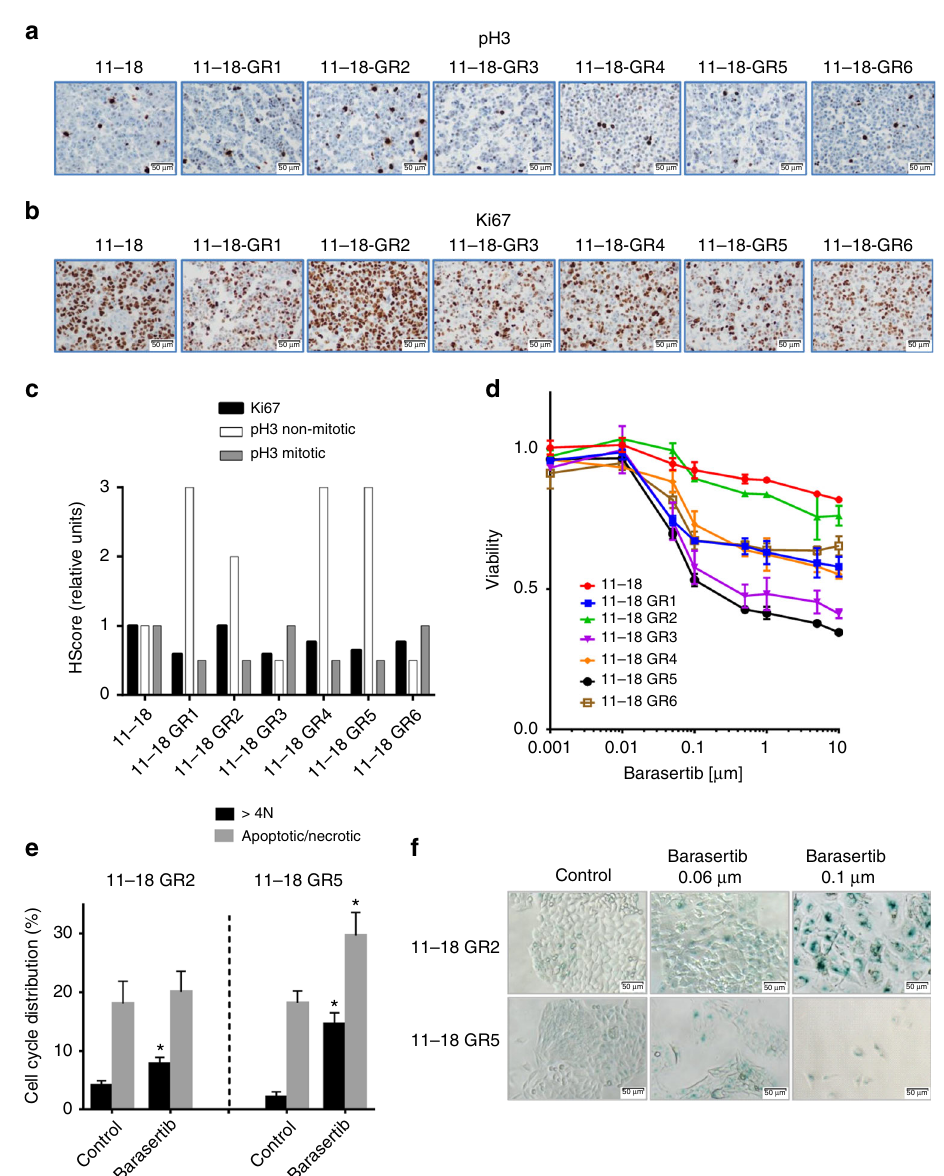
Fig. 5 Levels of pH3 and AURKB inhibition in 11 – 18 derived cell lines resistant to ge fi tinib. a – c IHC of pH3 ( a ), Ki67 ( b ), and H-score ( c ) of Ki67, mitotic pH3 and non-mitotic pH3 in the six EGFR -mut cell lines resistant to EGFR TKIs. Scale bars indicate 50 μ m. Values shown are means of two blind determinations performed independently by two expert pathologists ( n = 2). d Dose-response curves of the parental and the EGFR-TKI-resistant cells to the AURKB inhibitor barasertib. Values shown are means ± SD, experiments were conducted in tripicates ( n = 3). In each experiment, every concentration of drug was tested in sextuplicates ( n = 6). e Results of fl ow-cytometry experiments in 11 – 18-GR2 ( NRAS Q61L) and GR5 ( NRAS wt) showing polyploidy after 24 h treatment with barasertib (0.1 µ M) and apoptosis in 11 – 18-GR5 but not in GR2. Results shown are means ± SD of three independent determinations ( n = 3) and asterisks indicate statistical signi fi cance ( p < 0.05) in a two-sided Student ’ s t -test. f Acidic beta-galactosidase staining of 11 – 18-GR2 and GR5 cells